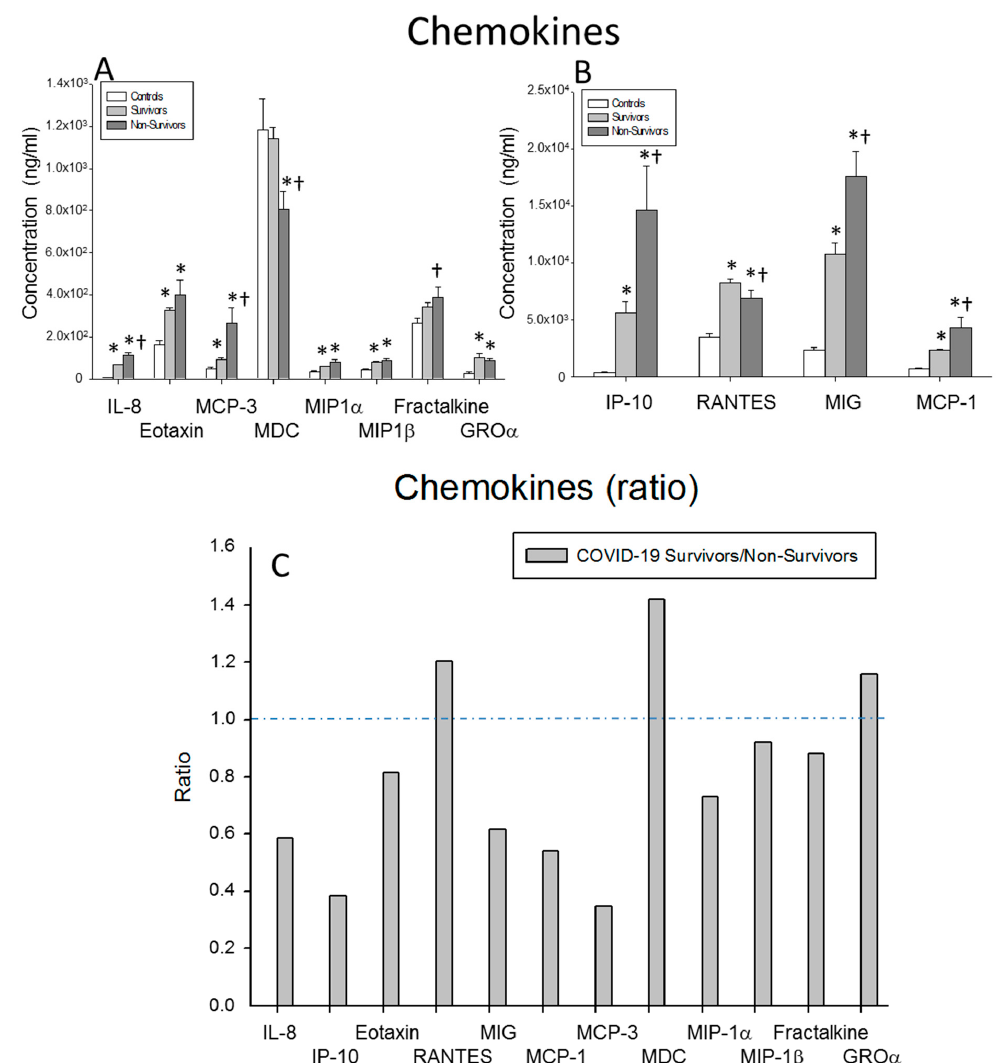
Figure 5. Adaptive cytokine results. ( A – C ) Data represent the concentrations of the cytokines and